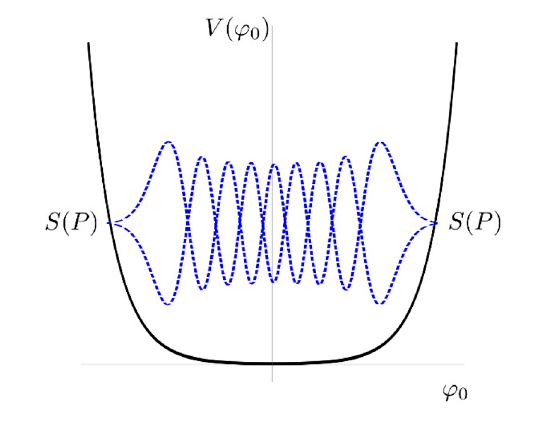
Figure 16. Standing waves of the zero mode ruled by the quantization condition eq.